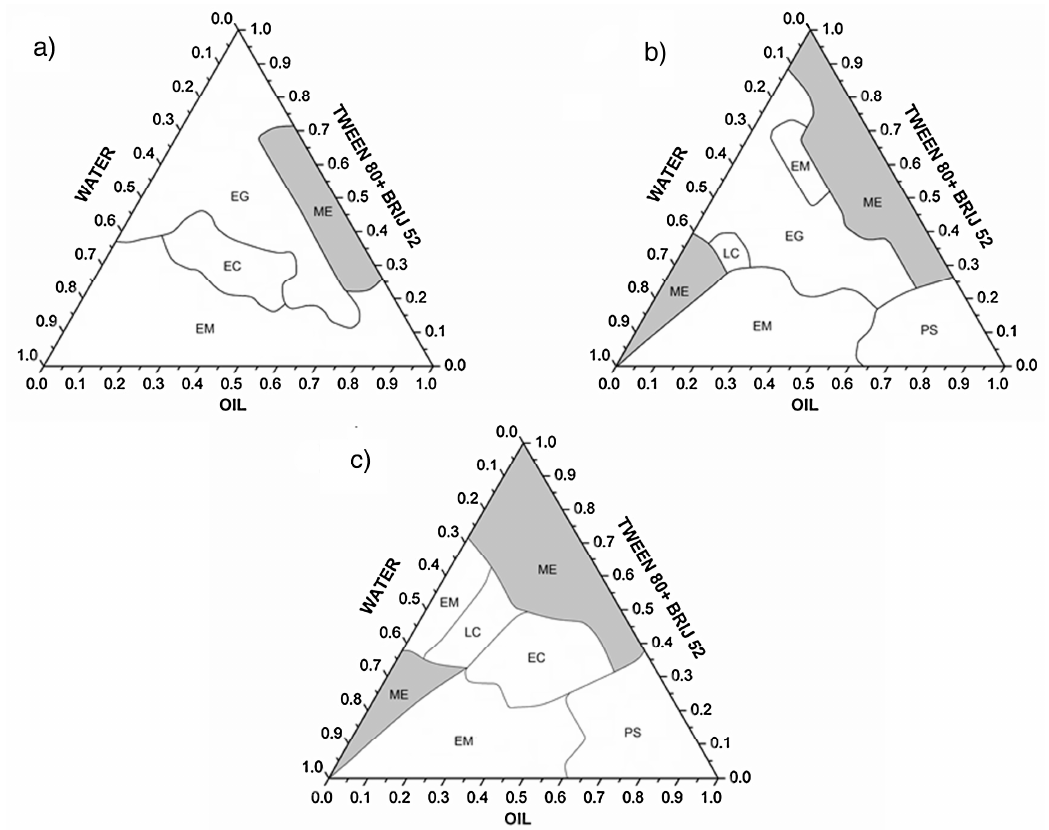
Figure 3. Pseudo-ternary phase diagrams formed by a mixture of caprylic/capric triglycerides as the oil phase, Tween 80: Brij 52 at 7:3 ( a ), 8:2 ( b ) and 9:1 ( c ) surfactant mix-ratio and water. Gray area represents the microemulsion systems (ME). Liquid crystal (LC), emulsion (EM), emollient gel (EG), emollient cream (EC), phase separation (PS). Reproduced with permission from [43].